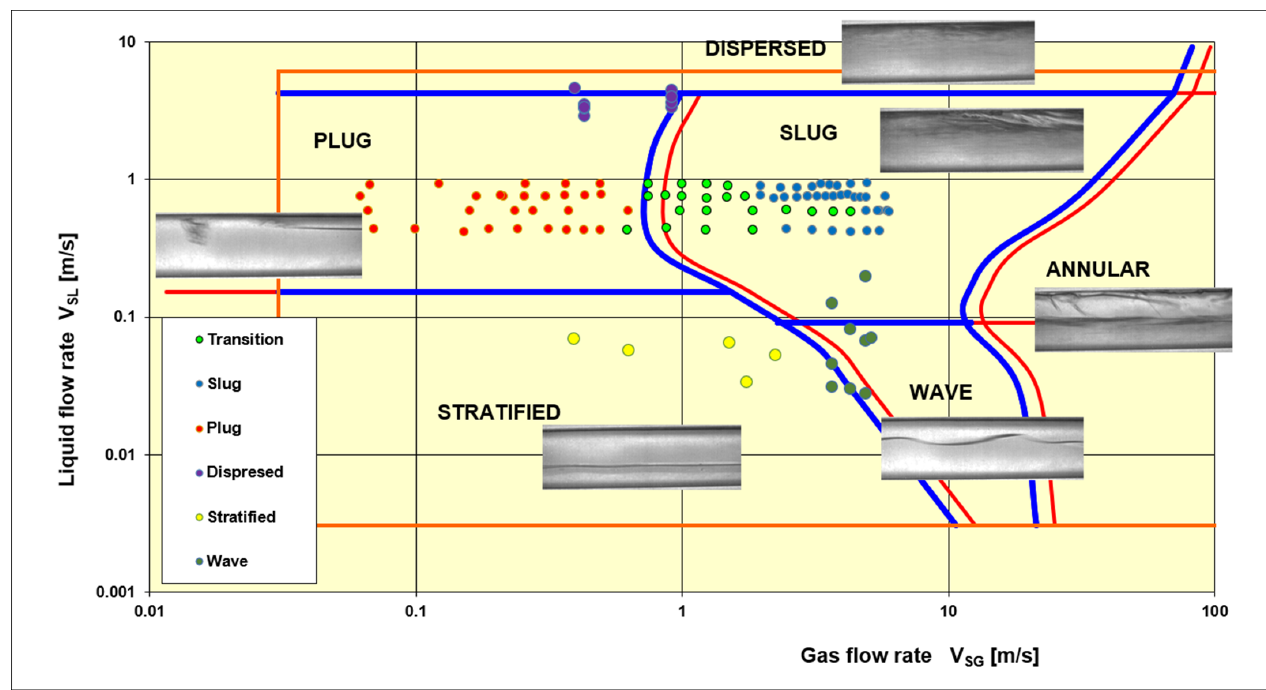
Figure 6. The flow map for the research setup. The tested set of flow types is marked. The crisp borders are highlighted with blue but the transitional areas with red. The images present the specified flow types captured with CCD camera.